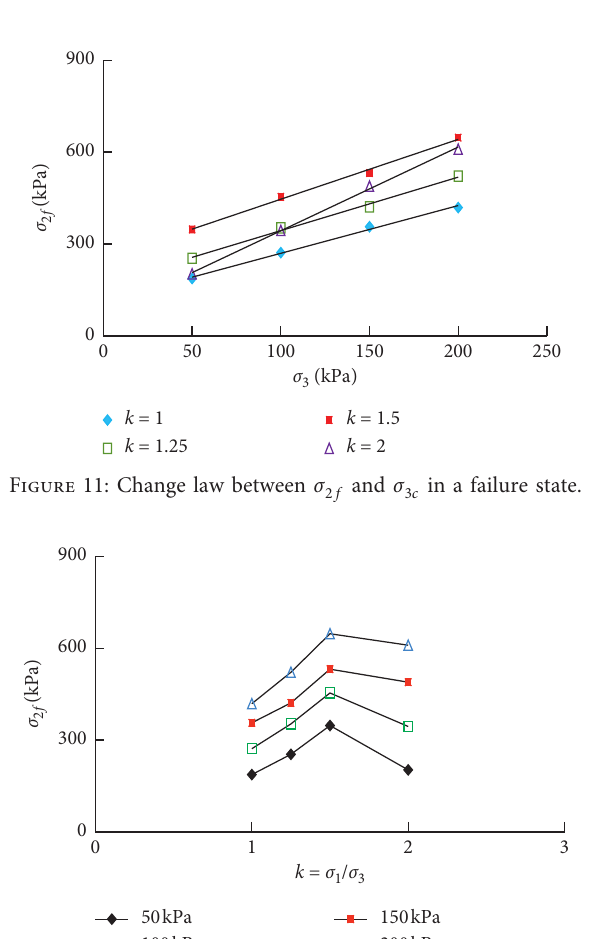
and k in a failure state. 2 f